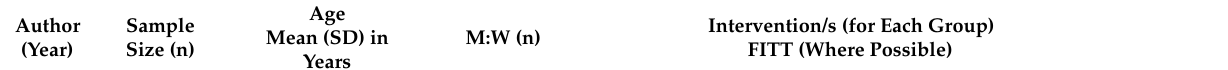
Table 2. Data extraction table for the included